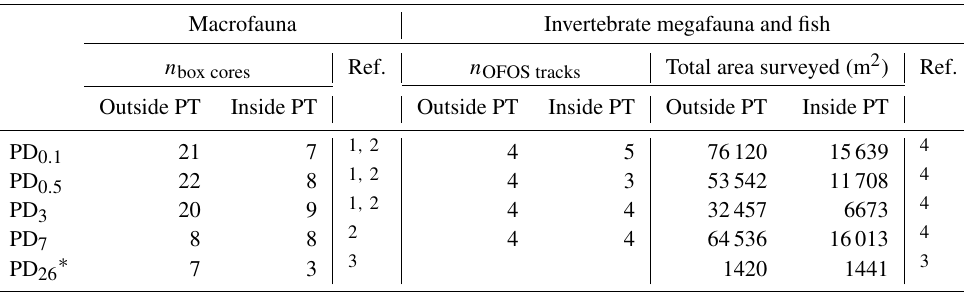
mean, taxon-specific, individual biomass value for macro- fauna (mmol C ind − 1 ; Table 2). Subsequently, the carbon stock data of all taxa with the same feeding type (Table 2) were summed to calculate the carbon stock of each macro- faunal compartment (mmol C m − 2 ; Supplement 2, Fig. 2). The invertebrate megafaunal density data (ind. m − 2 ) of